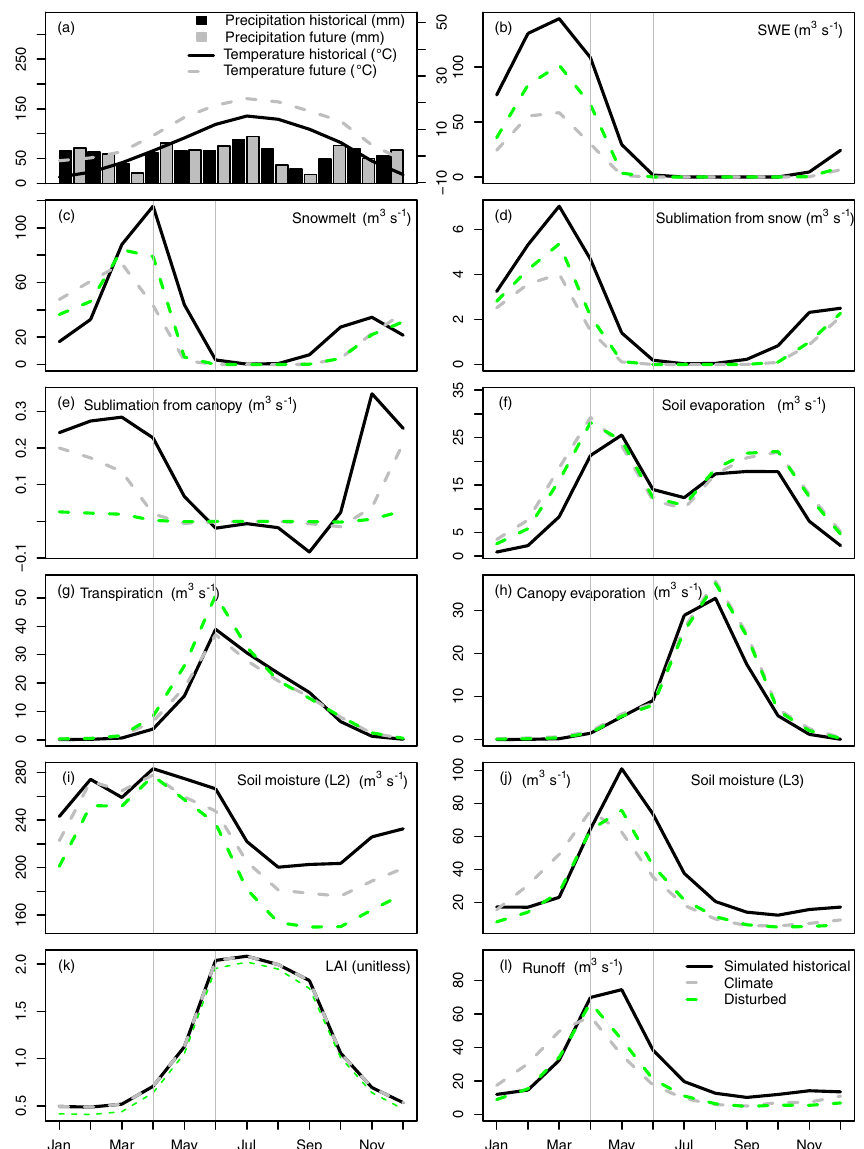
Figure 4. Monthly water balance panels for forested (greater than 50%) regions in the San Juan River basin. Panels include precipitation (mm) and temperature ( ◦ C) for historical (1970–1999, black) and future (2070–2099, grey, a ), snow water equivalent (SWE, m 3 s − 1 , b ), snowmelt (m 3 s − 1 , c ), sublimation from snow (m 3 s − 1 , d ), sublimation from canopy (m 3 s − 1 , e ), soil evaporation (m 3 s − 1 , f ), transpiration (m 3 s − 1 , g ), canopy evaporation (m 3 s − 1 , h ), soil moisture from second soil later (L2, m 3 s − 1 , i ), soil moisture from the third soil layer (L3, m 3 s − 1 , j ), leaf area index (LAI, unitless, k ), and runoff (m 3 s − 1 , l ) for simulated historical (black line), climate-only (grey line), and disturbed scenarios (green line). The months of April and June are indicated with vertical grey